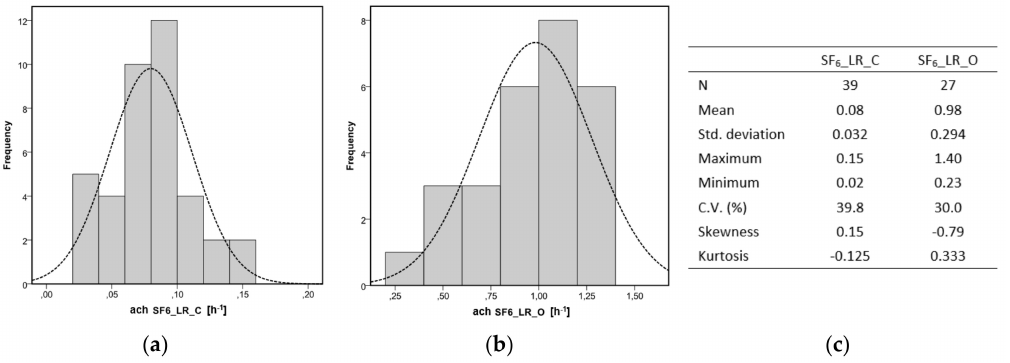
Figure 4. Sulfur hexafluoride (SF 6 ) measurements of the air change rate in the living room (LR): ( a ) Histogram—door closed (SF 6 _LR_C); ( b ) Histogram—door open (SF 6 _LR_O); ( c ) Descriptive statistics indicators.